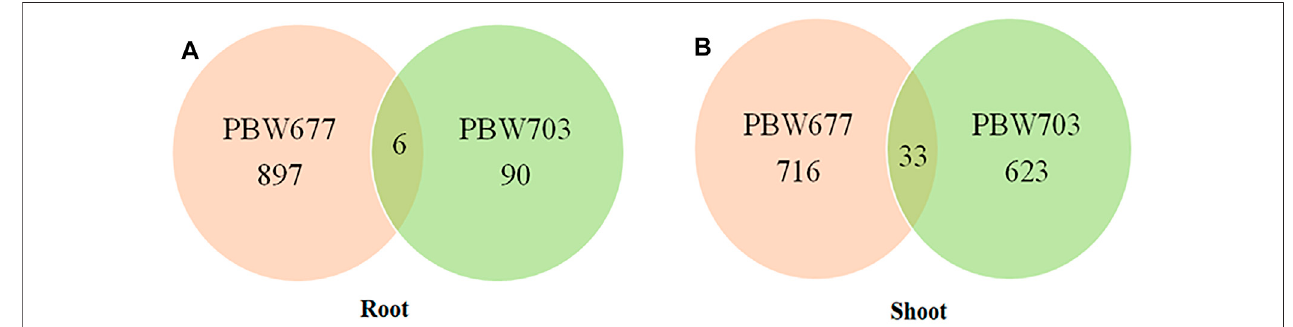
FIGURE 5 | Common DEGs (differentially expressed genes) in root and shoot tissues of (A) PBW677 and (B)